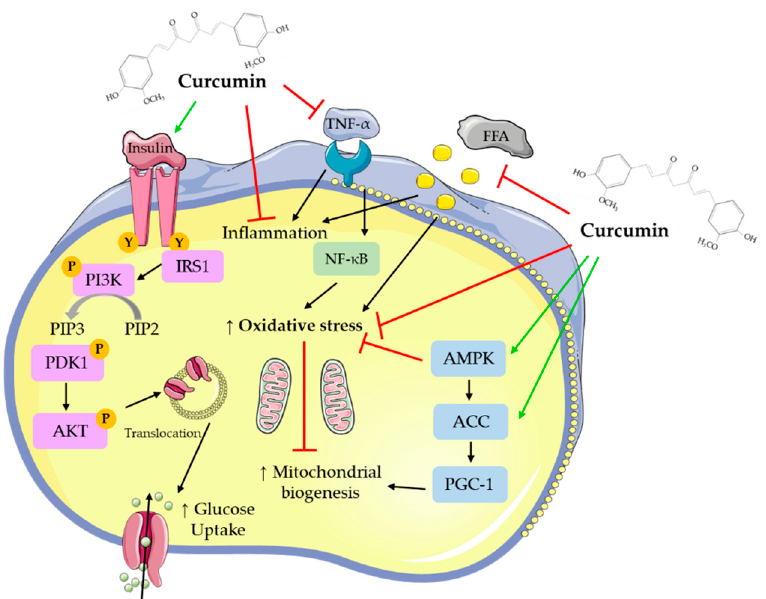
Figure 2. Cellular effects of curcumin on muscle and fat cellular signaling molecules. The figure was created based on the data of the studies [40,41,43–46,57,67,73,97,98,101,102]. AKT: protein kinase B;